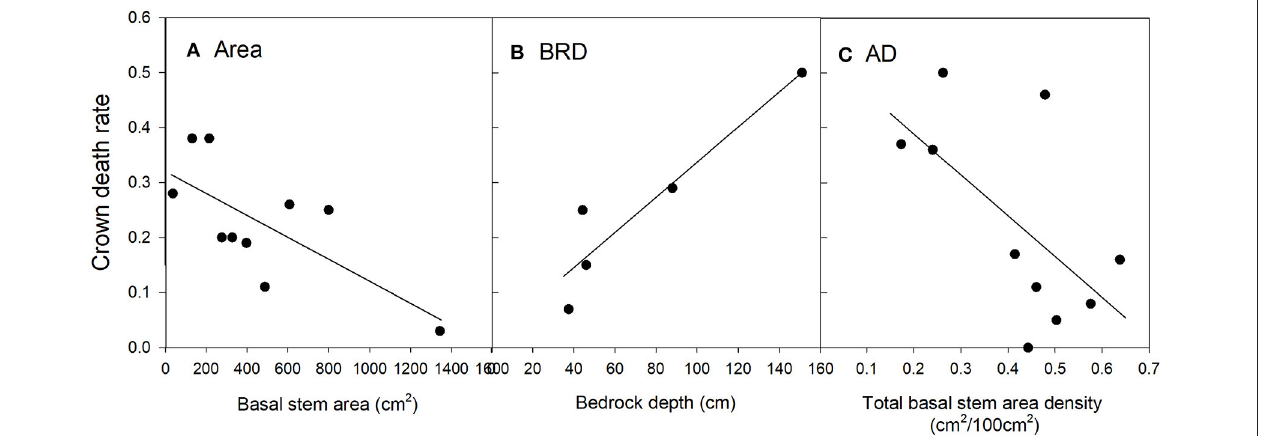
FIGURE 4 | Relationships between live oak crown death rate and significant risk factors in the top regression model (O1). The values of the risk factors were divided into classes of individual basal stem area (A) , bedrock depth (B) and the basal stem area density of all tree species (C) . Data were binned into 10 (Area, AD), or 5 (BRD) classes with approximately equal membership and the class average was plotted on the x-axis. The smaller number of bins were dictated by the granularity of the data. See Table 2 for an explanation of variable names.